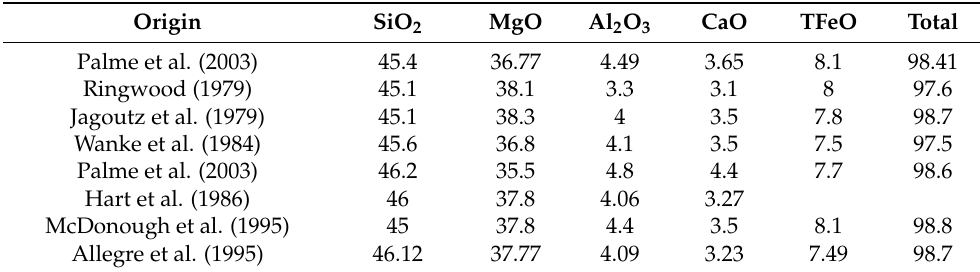
Table 7. Oxide contents of the global primitive mantle peridotite (wt.%)